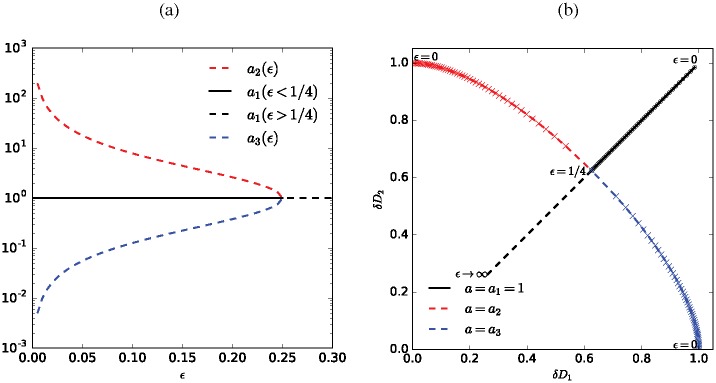
Linear stability.Solutions a1, a2 and a3 for the coefficient a linking D1 and the corresponding three equilibria for ϵ < 1/4. The symbols are equidistantly spaced in the range 0 < ϵ < 1/4 with Δϵ = 0.005. For ϵ ≥ 1/4, only one equilibrium exists which is shown by the dashed black line. Line style indicate the stability of the respective equilibrium where dashed corresponds to unstable and solid corresponds to stable equilibria.